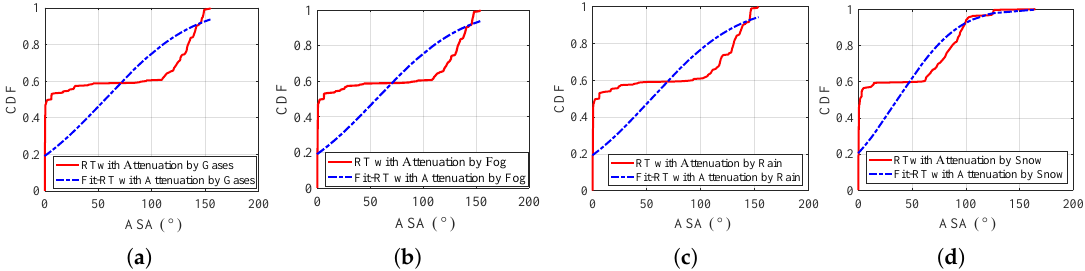
Figure 13. ASA (azimuth angular spread of arrival), ( a ) by Gases; ( b ) by Fog; ( c ) by Rain; ( d ) by Snow.